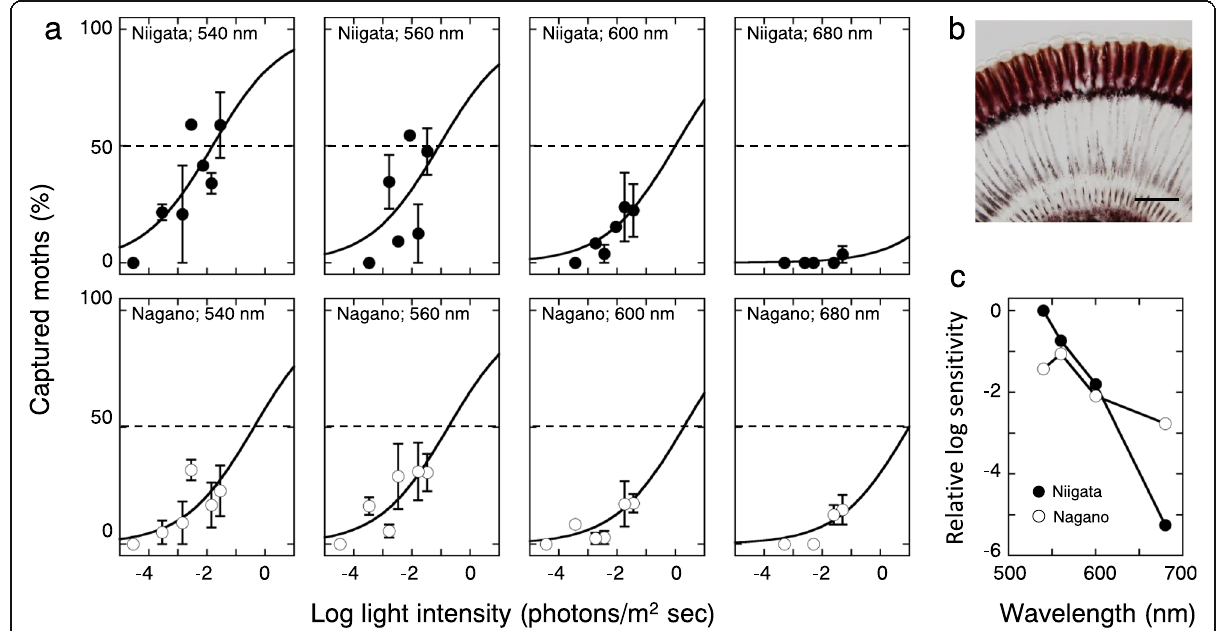
Fig. 6 a Phototactic response to four monochromatic lights for Niigata and Nagano strains. Percentage of captured individuals is plotted against the light intensity. Eight to 14 individuals were used in each trial. Mean ± standard error. b A longitudinal section of a partially light-adapted eye of a Niigata individual. c Action spectra of the Niigata (filled circles) and Nagano (open circles)